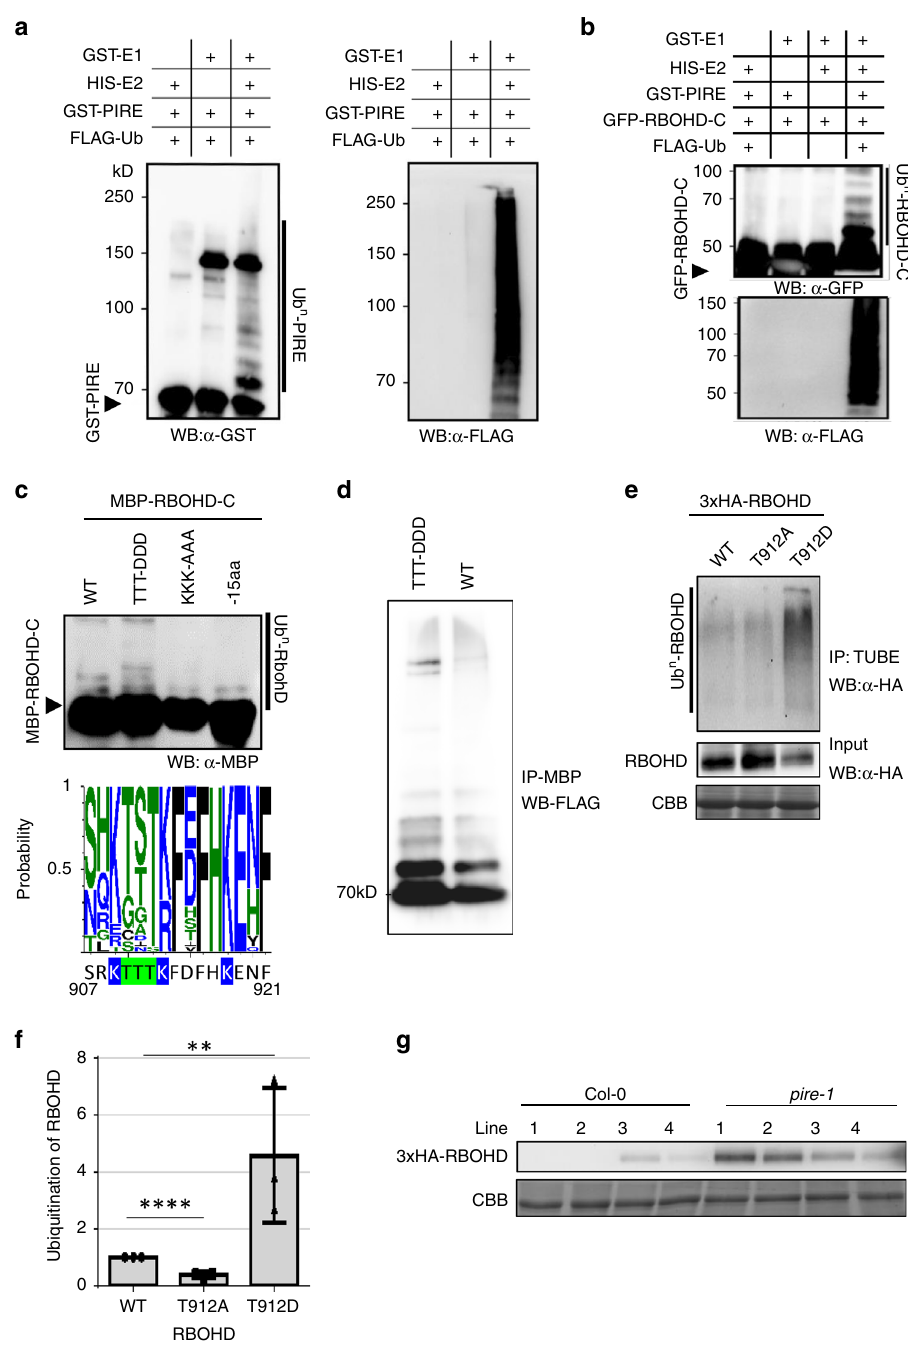
proteins subjected to anti-FLAG western blot to detect FLAG- tagged ubiquitin (Fig. 4d). After puri fi cation, the phosphomimetic mutant (RBOHD T910DT911DT912D ) exhibited enhanced ubiquiti- nation compared to wild-type RBOHD (Fig. 4d). Similar to